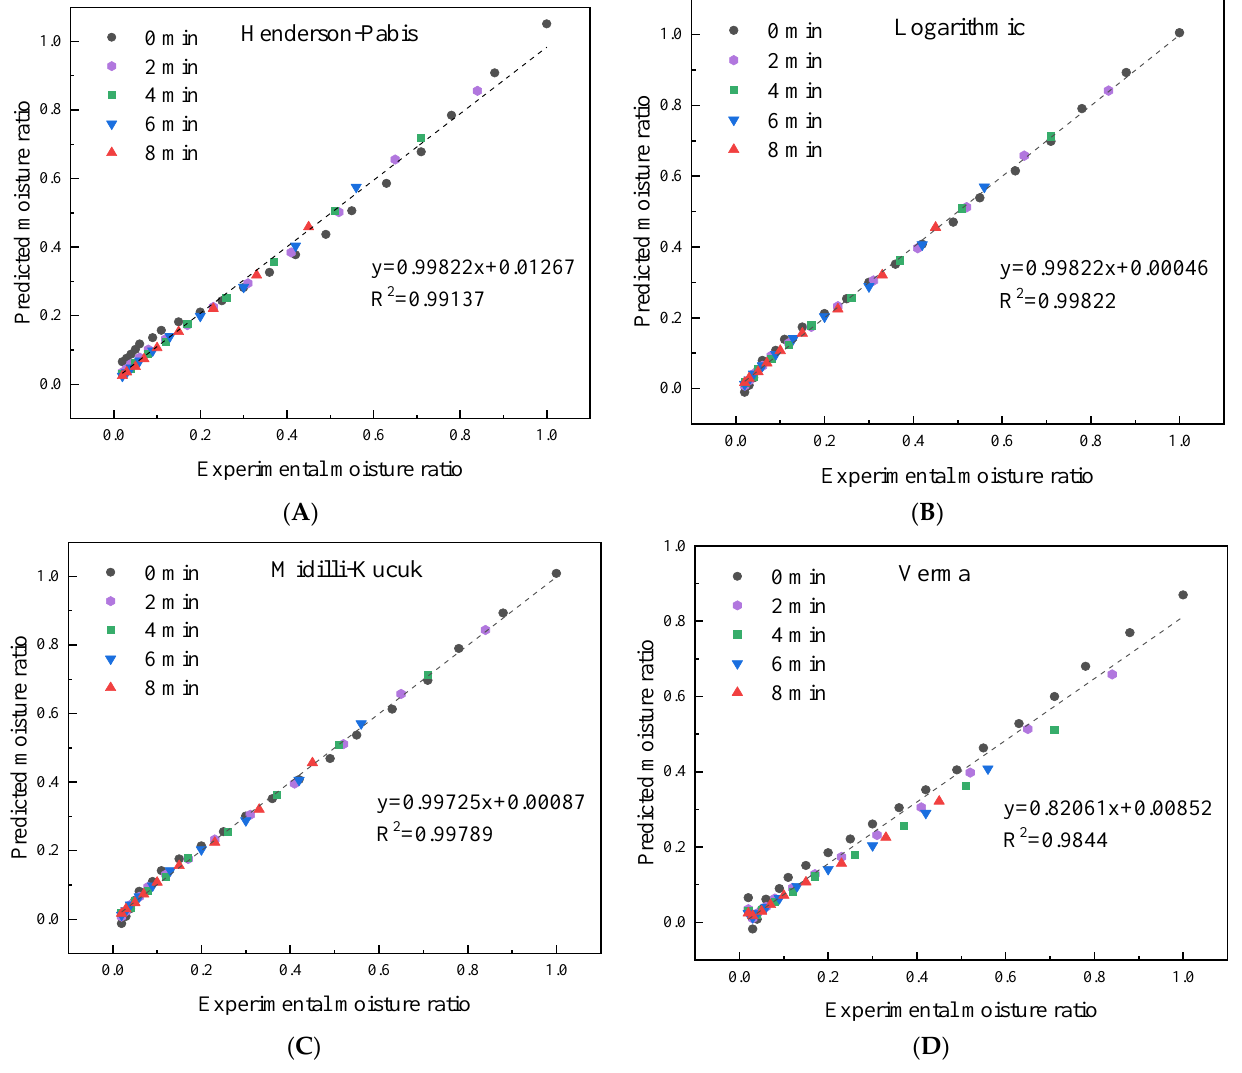
Figure 4. Experimental and predicted moisture ratio of A. sessiliflorus fruits with different blanching durations. ( A ) Henderson – Pabis model; ( B ) Logarithmic model; ( C ) Midilli – Kucuk model; and ( D ) Verma model.